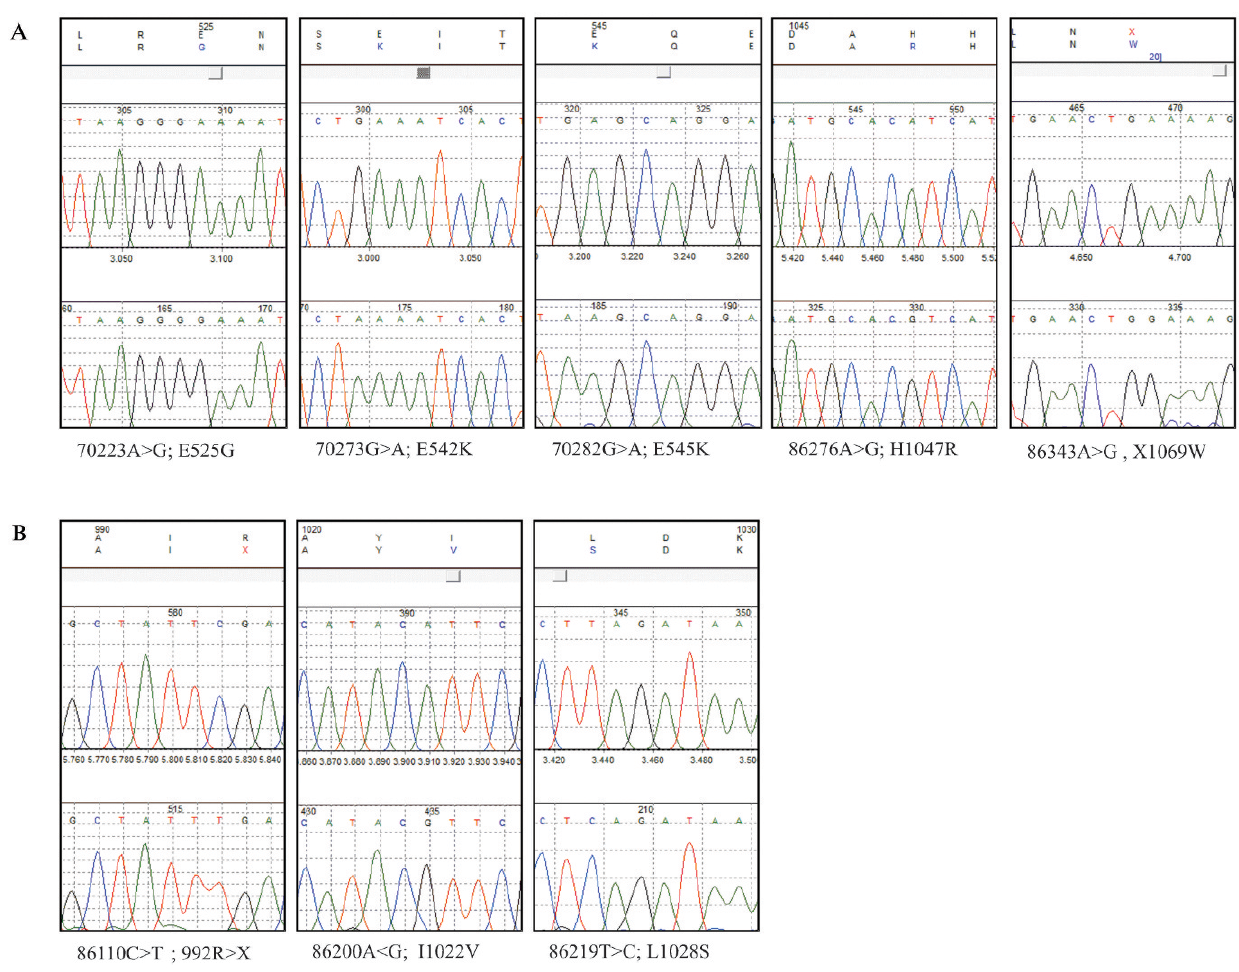
Figure 1 - Representative eletropherograms of the PIK3CA mutations characterized in the breast cancer biopsy samples in this study. (A) Known mutations and (B)